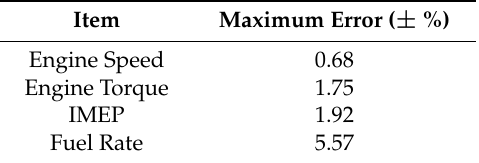
Table 4. Maximum error in the experimental results of the engine